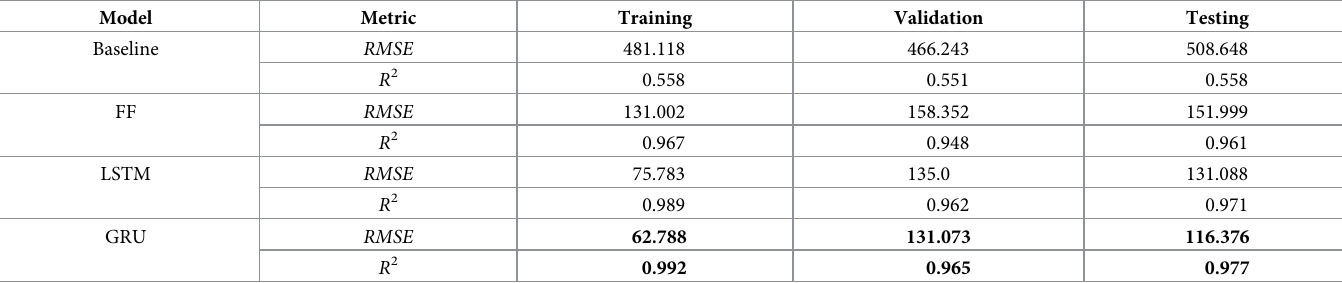
Table 2. RMSE and R 2 metrics for the training, validation, and testing data subsets. The best performing values of RMSE and R 2 for each subset are in bold.